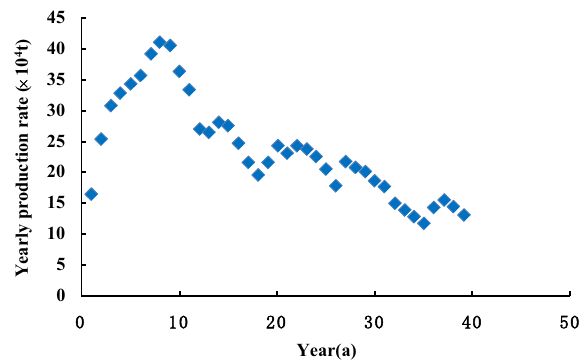
Fig. 2 Relation curve between oil production rates over time of M oilfield